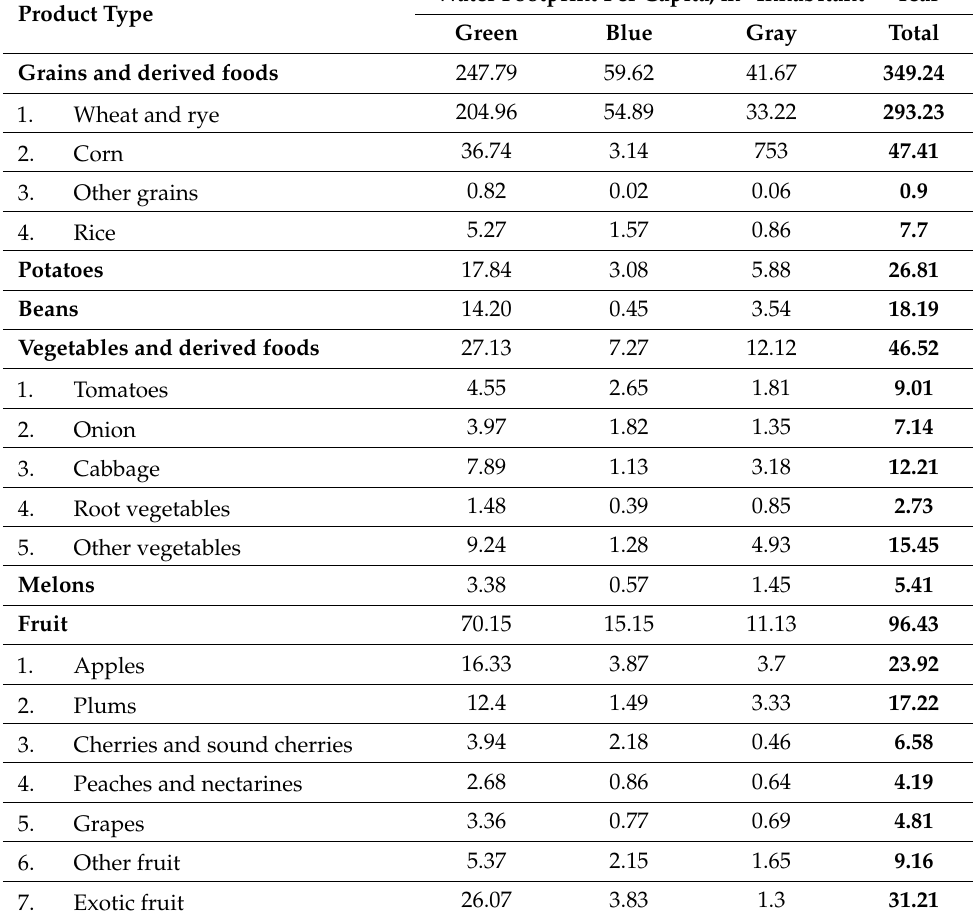
Table 3. Results water footprint per